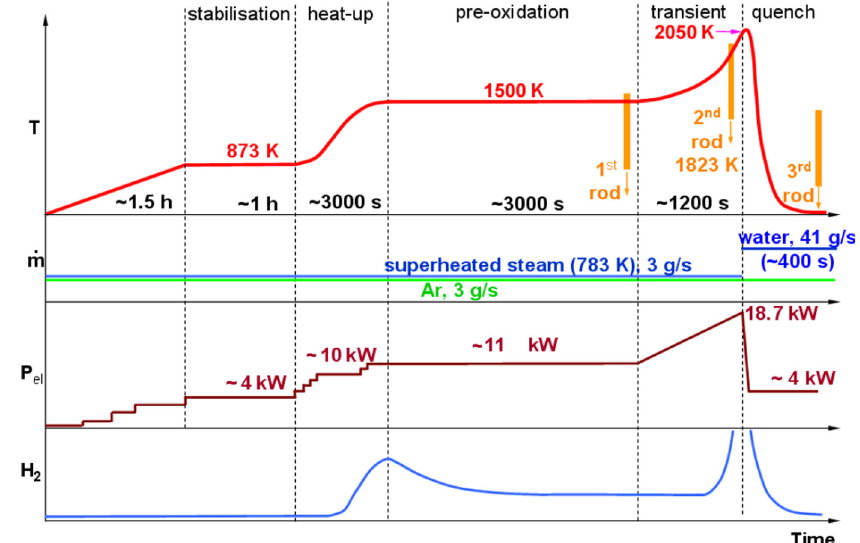
Fig. 1. Phases of the QUENCH-14 experiment